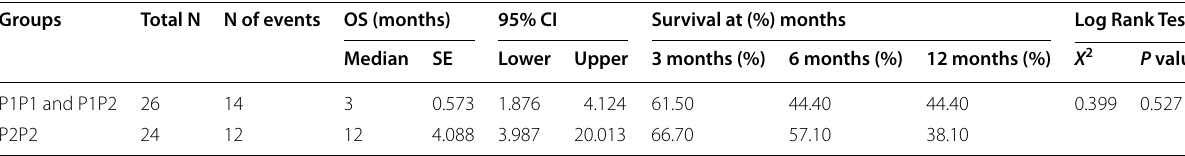
OS overall survival, SE standard error, N number